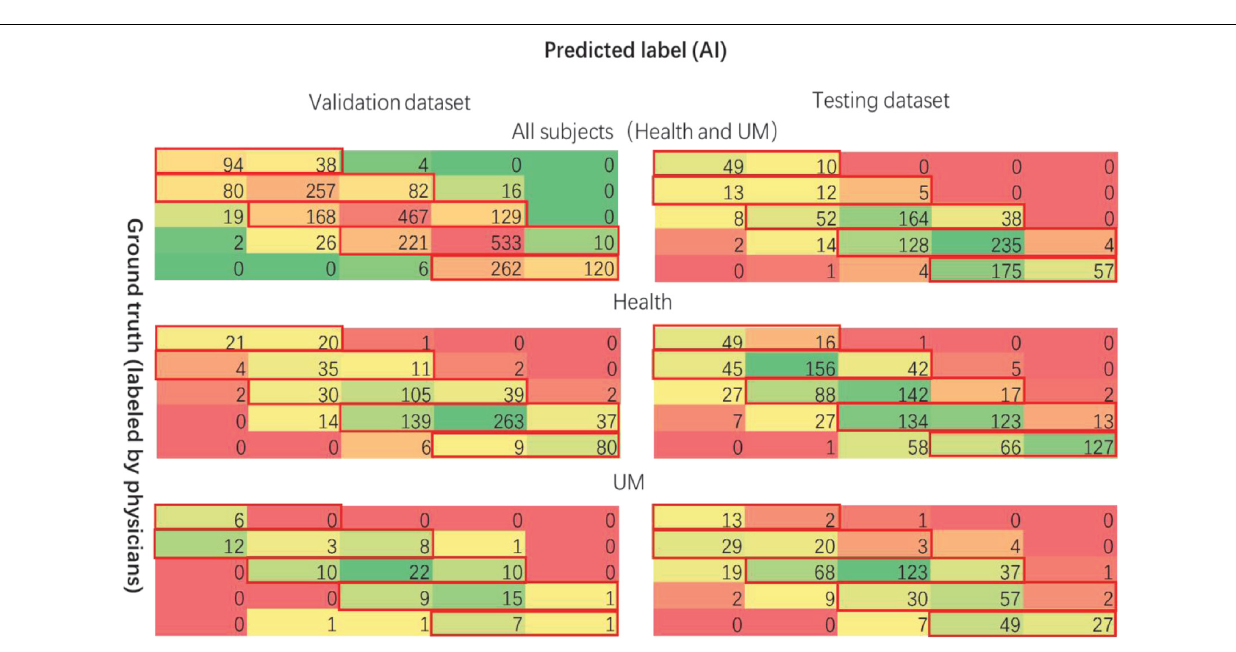
Frontiers in Cell and Developmental Biology |